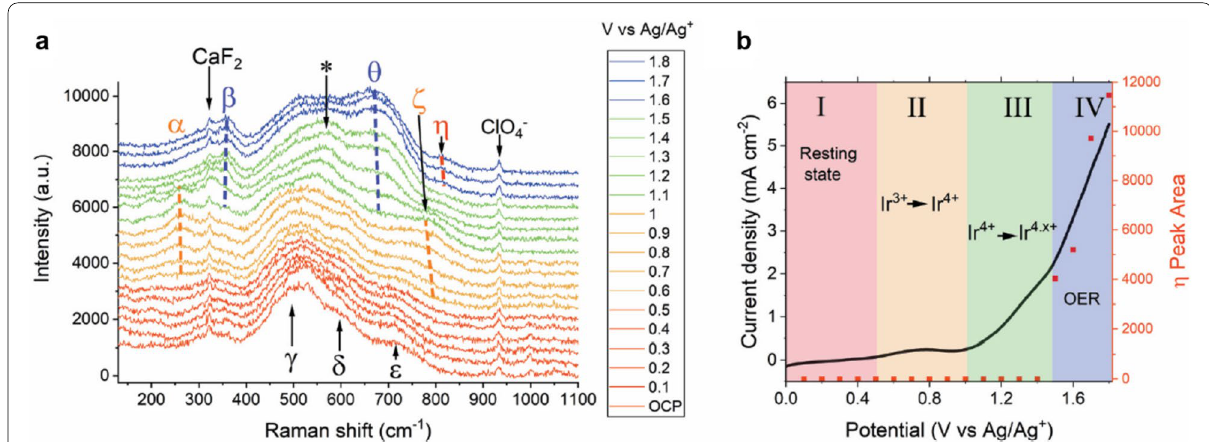
Fig. 9 a In situ Raman spectra of an Au@SiO 2 particle-coated IrO x film measured in a 1 M NaClO 4 (pH 10) electrolyte at various potentials. b OER current density and η peak area as a function of the potential. The voltammogram was measured at a scan rate of 5 mV s − 1 in 1 M NaClO 4 (pH 10) adjusted with NaOH, reproduced with permission from [46]. Copyright (2020) The Royal Society of